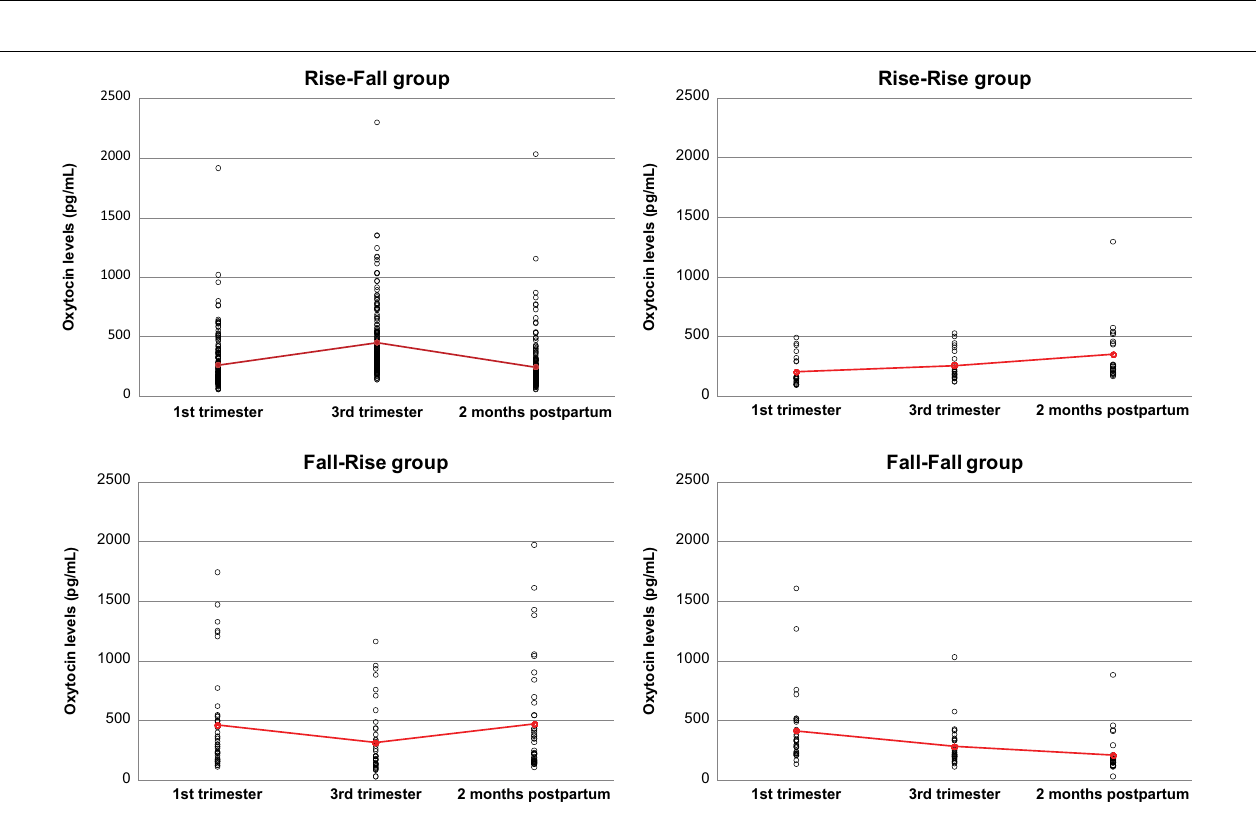
FIGURE 1 | Plasma oxytocin levels during the pregnancy and postpartum periods . Red crosses indicate mean values for each time period.